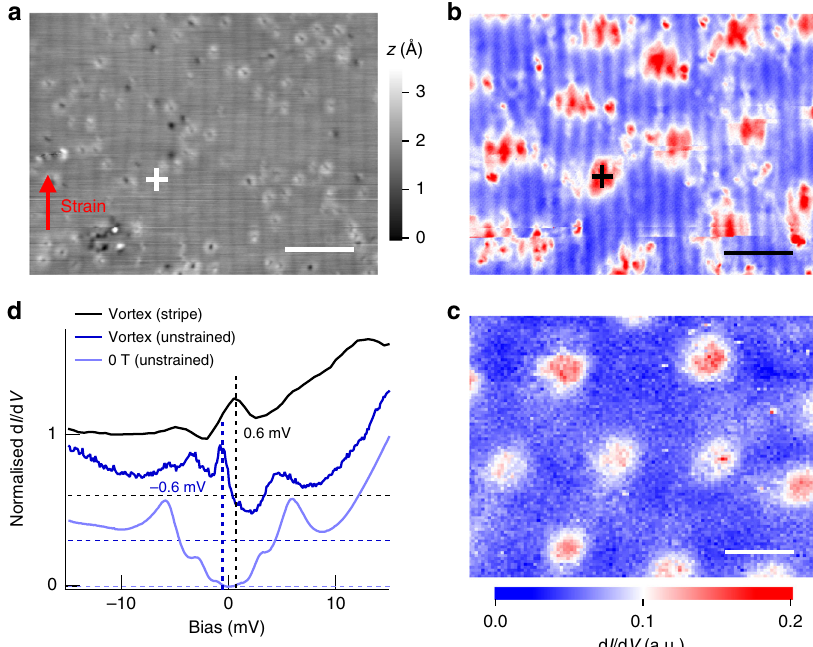
Fig. 3 Vortices in the modulated phase. a Topographic image of the modulated phase taken in the presence of 9 T out-of-plane fi eld at T = 4 K ( V s = 25 mV, I s = 50 pA). A red arrow indicates the direction of the strain. b Corresponding d I /d V map recorded at zero bias. Vortices are seen as areas of high zero bias conductance (red). c d I /d V map taken at bias voltage of − 0.5 mV on an unstrained sample in the presence of an out-of-plane fi eld of 5T at 1.2 K. Scale bars in a – c : 12.5 nm. d d I /d V spectrum taken in the centre of one of the vortices formed on the modulated phase (black, the position is marked with a cross in a , b and those on the surface of an unstrained LiFeAs crystal (mid-blue), respectively. An averaged spectrum taken from a defect-free region on unstrained LiFeAs at 0T, 1.2 K (light-blue) is included for reference. Spectra are vertically offset for clarity. Dashed horizontal lines indicate the positions of zero conductance for each spectrum. For b , c , V s = 25 mV, I s = 0.3